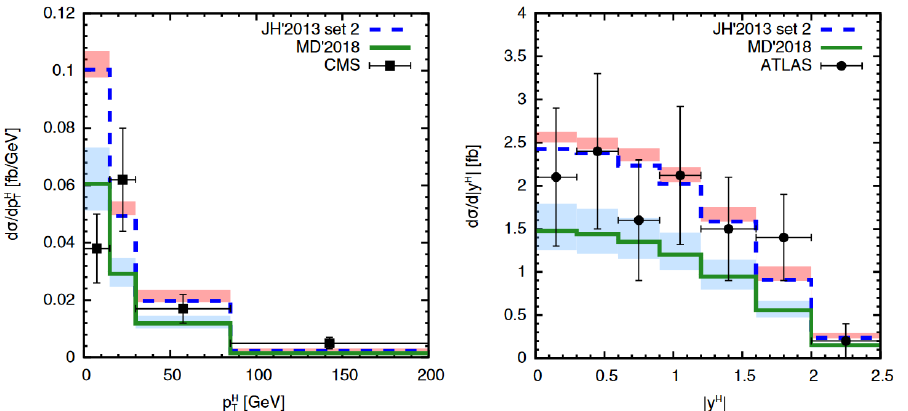
Figure 7. The differential cross sections of inclusive Higgs production (in the H → ZZ ∗ → √ 4 l decay mode) at s = 13 TeV as functions of Higgs boson transverse momentum p H rapidity | y H | . Notation of the histograms is the same as in Fig. 1. The experimental data are from CMS [27] and ATLAS